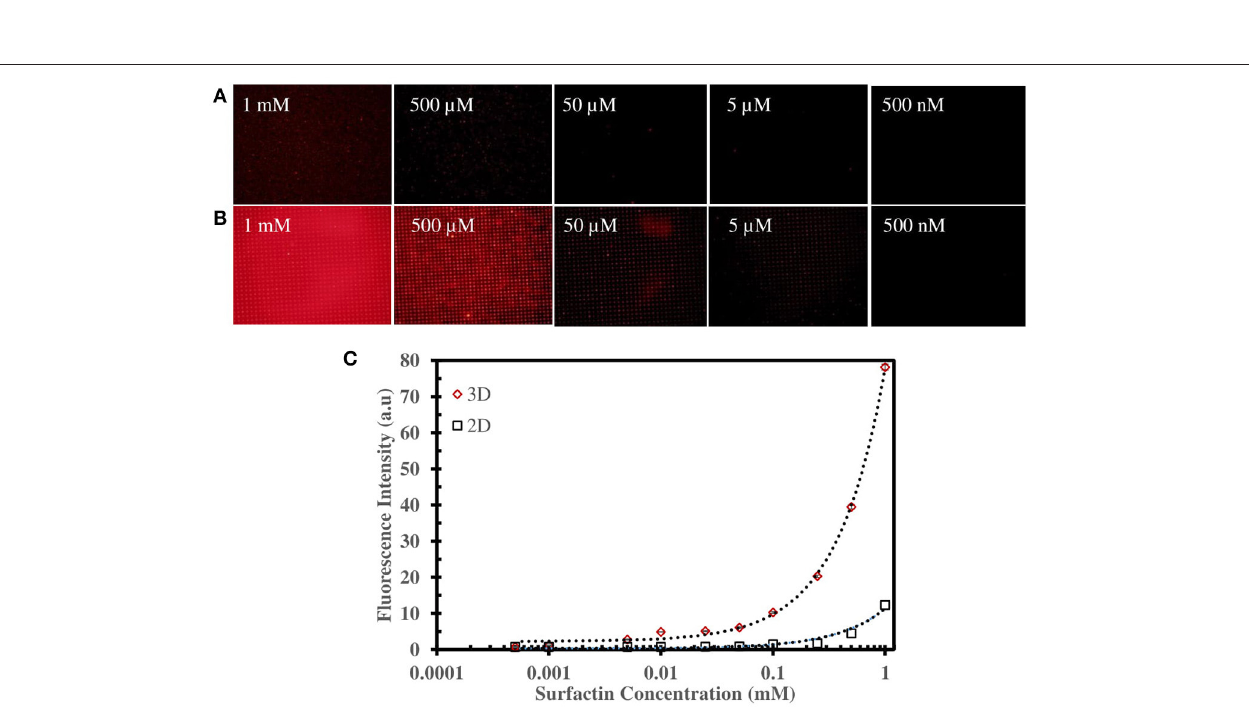
Frontiers in Materials |